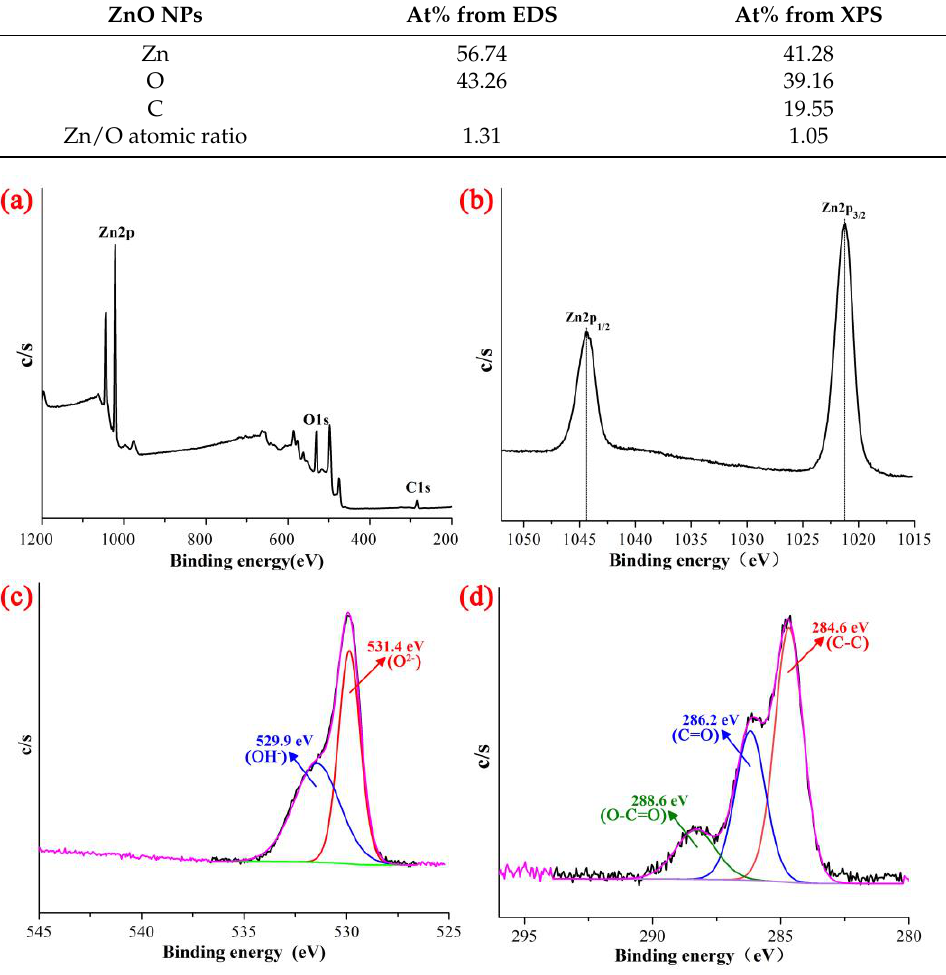
Figure 4. XPS spectra of ZnO NPs ( a ), Zn 2p ( b ), O 1s ( c ) and C 1s ( d